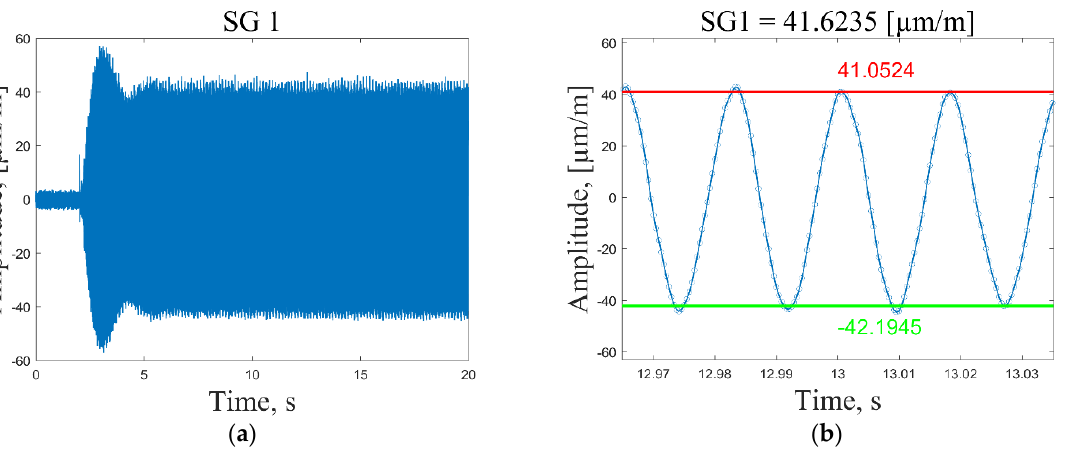
Figure 11. Recorded time series of strain response of the plate excited by a periodic sine wave signal corresponding to the first resonant frequency with a 3 V peak-to-peak vibration amplitude ( a ); calculated average peak-to-peak values for strain gauge 1 ( b ).